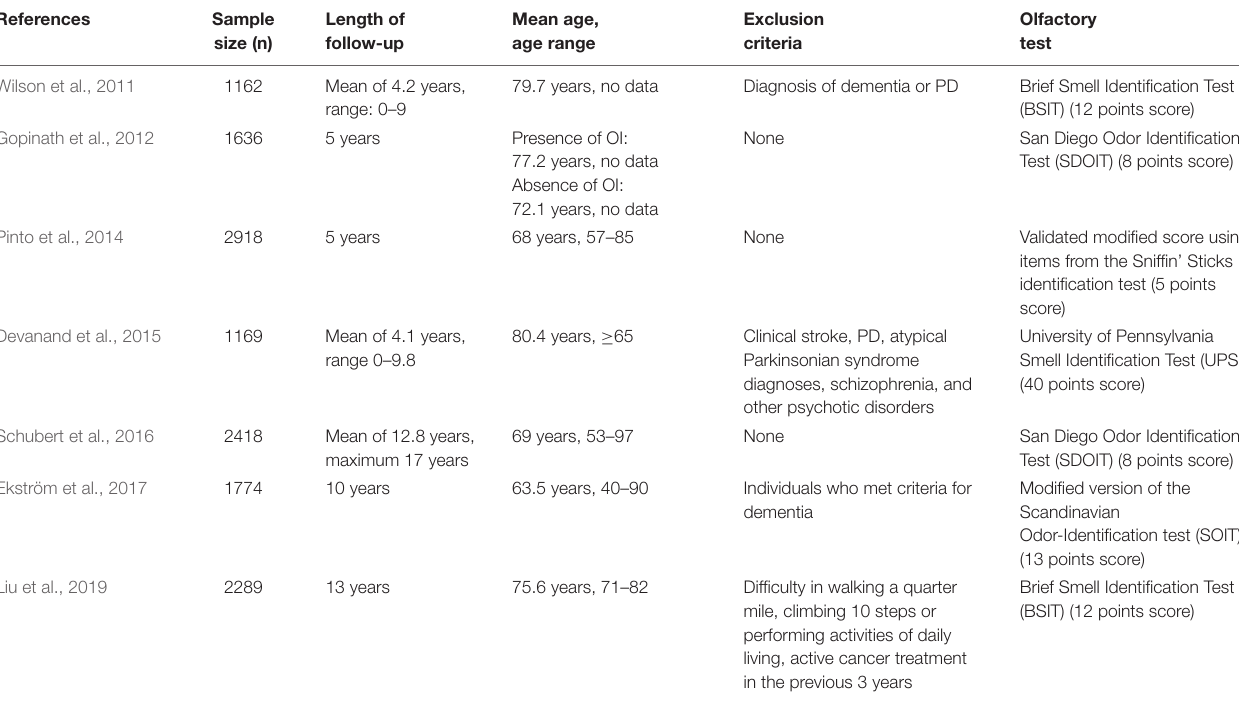
TABLE 1 | Studies linking olfactory impairment and mortality – Demographic data and